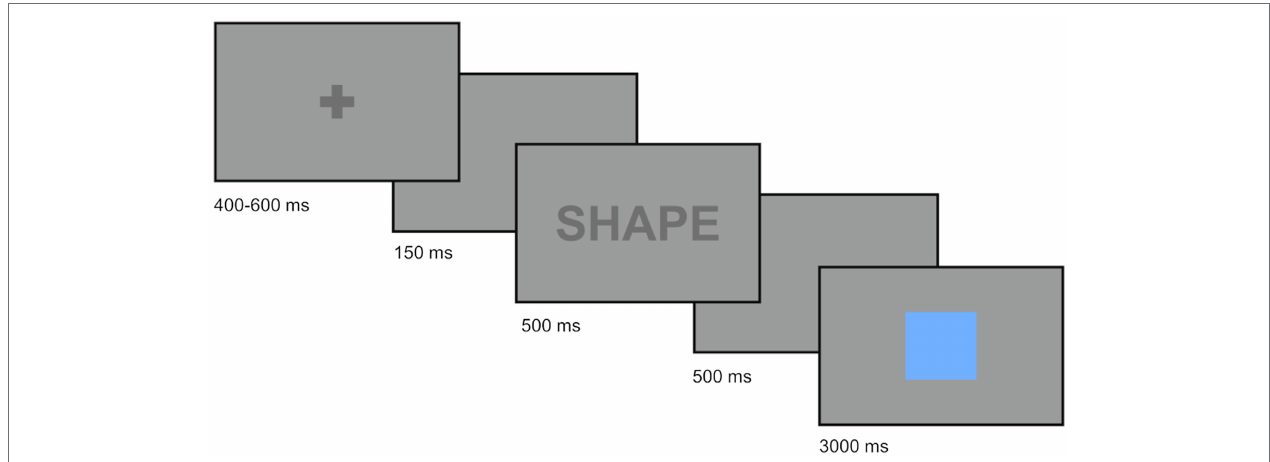
FIGURE 1 | Sample trial procedure for a mixed trial in the color-shape switching